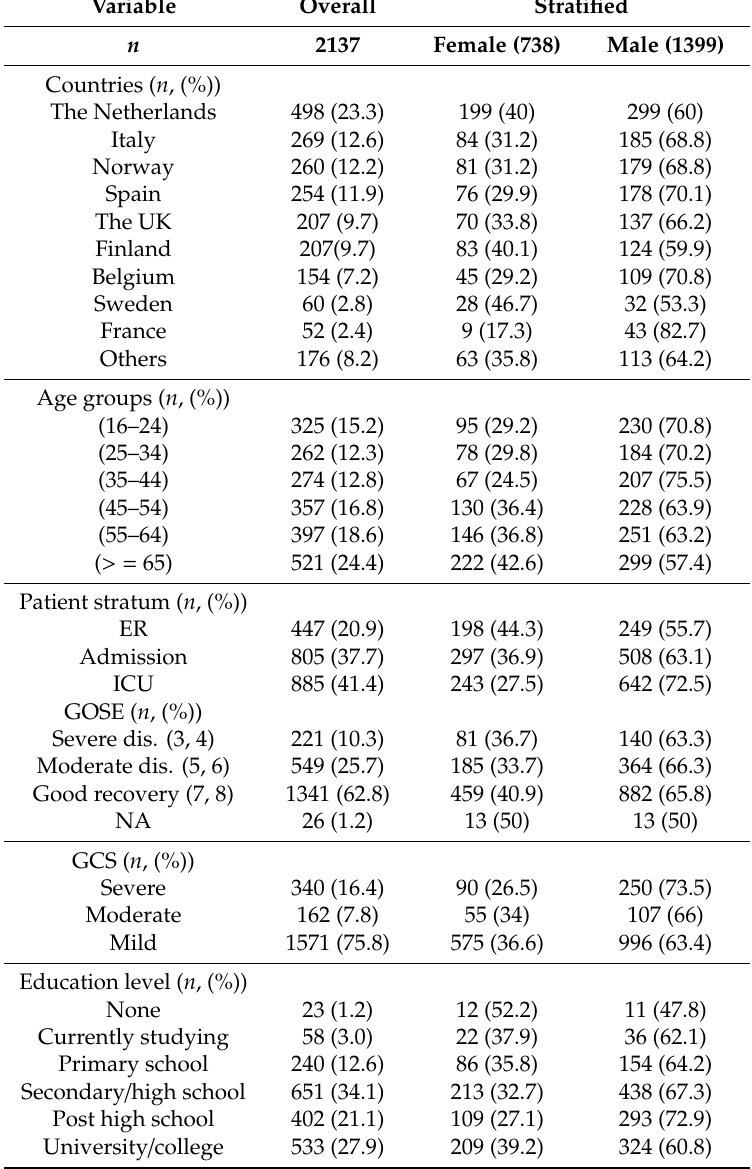
Table 1. Descriptive characteristics of the